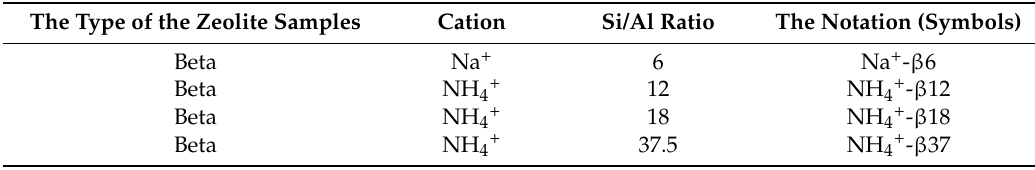
Table 5. Commercial Beta zeolites used for the postsynthetic modification.